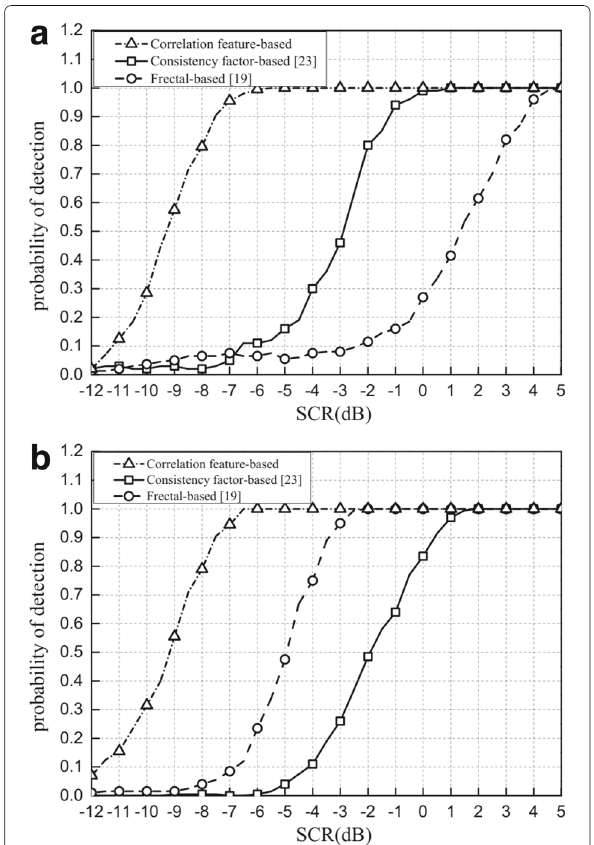
Fig. 7 Detection performance of proposed detector with different second detection thresholds. a target 1. b target 2